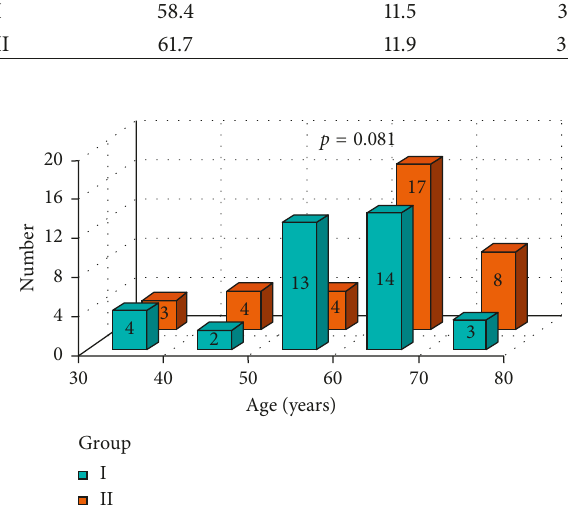
Figure 3: Age and result of Mann-Whitney test: comparison of both groups I and II.